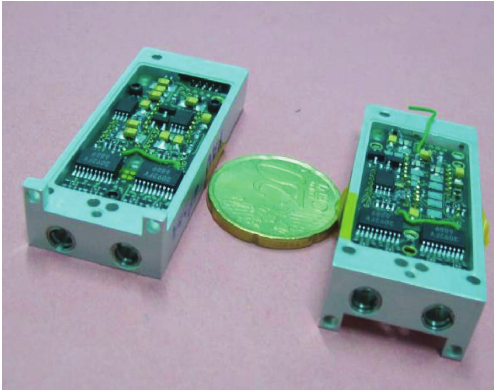
Figure 7: Simulated radiating pattern in receive.